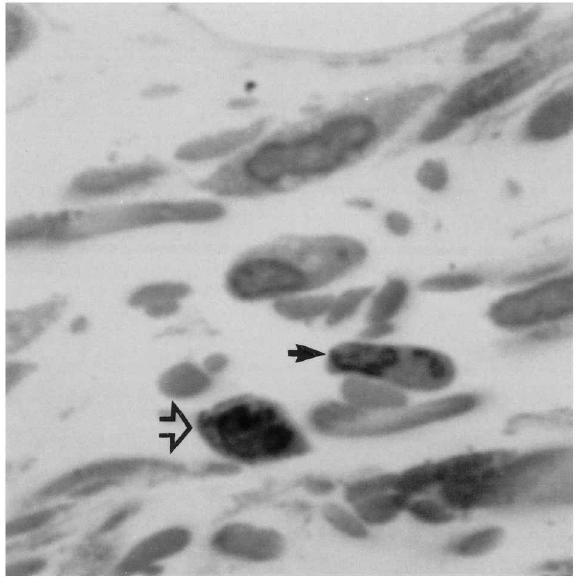
FIG. 1. Representative micrograph of the inflamed mesentery 4h post-carrageenin injection. Carrageenin was injected i.p. to rats, and the mesenteric tissue collected 4h later. Eosino- phils can be seen localised both intravascularly as well as in the extravascular tissue (open arrow). An extravascular neutrophil is indicated (closed arrow). Sections (0.5 m m) were stained with May–Grumwald and Giemsa ( ´ 1500).